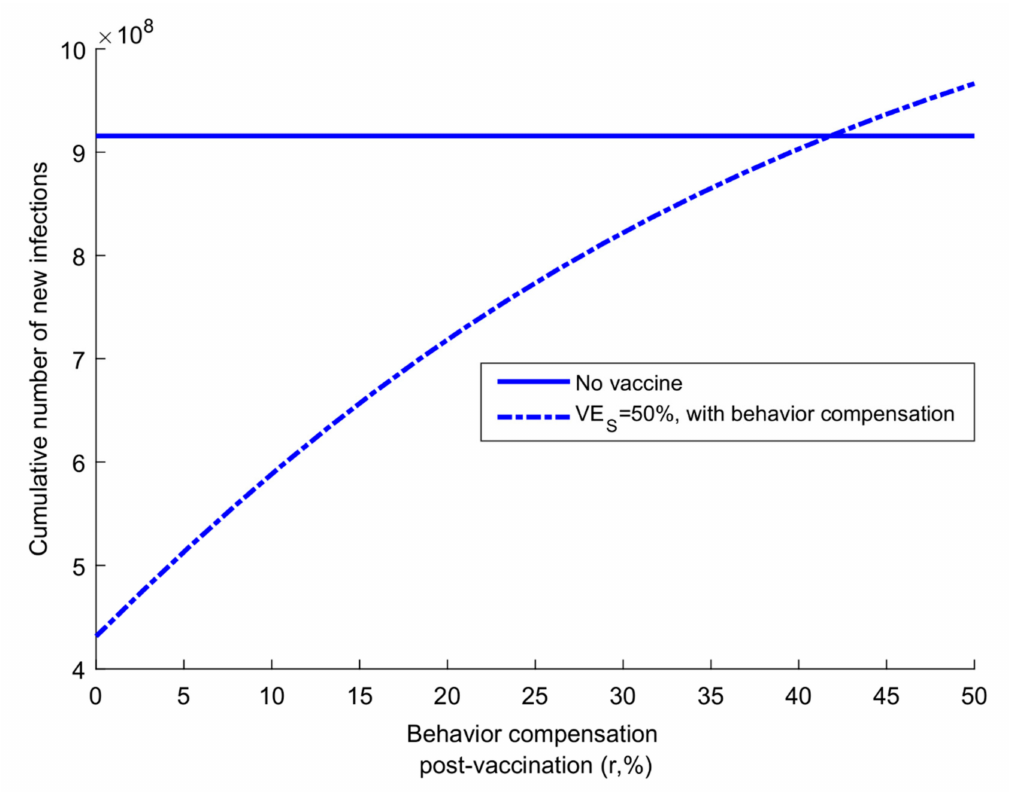
Figure 6. Impact of vaccination with reduced adherence to social distancing for those vaccinated. Figure shows the impact of varying levels of behavior compensation post-vaccination on the vaccine-induced reduction in the cumulative number of new SARS-CoV-2 infections by the end of the epidemic cycle. Scenario assumes vaccine scale-up to 80% coverage before epidemic onset, VE s is 50%, and duration of vaccine protection is 10